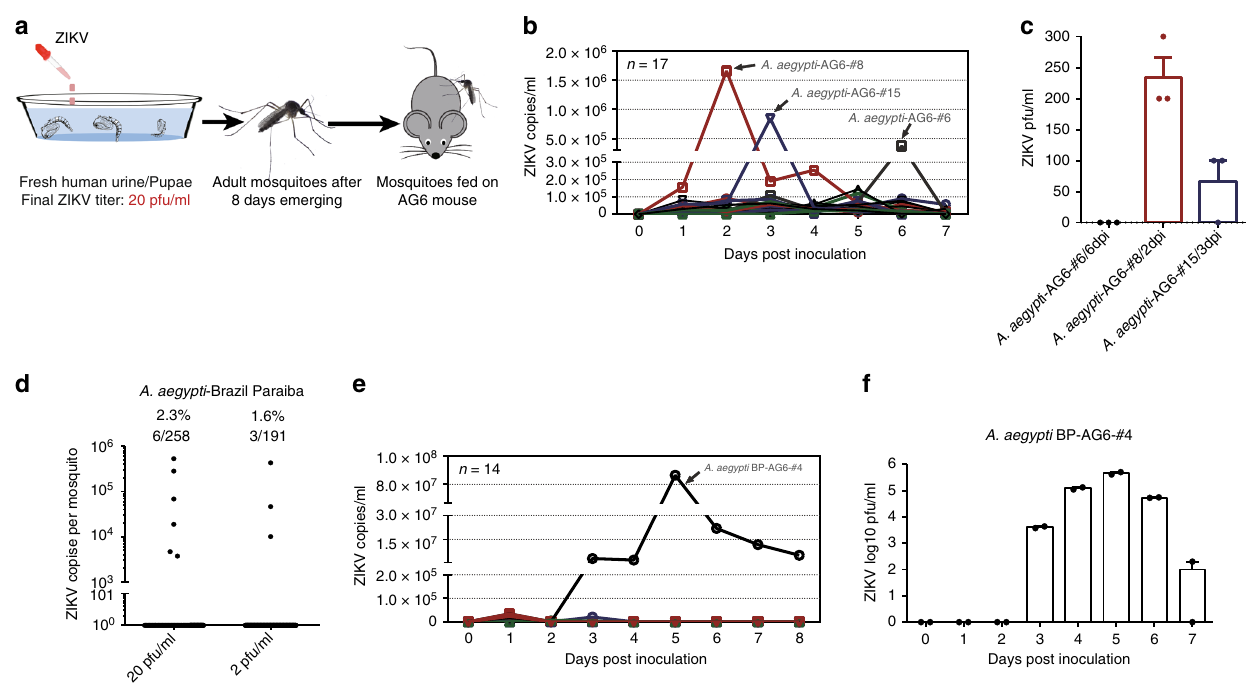
Fig. 2 Zika virus (ZIKV) is transmissible between AG6 mice and mosquitoes breeding in ZIKV urine. a Schematic representation of the ZIKV transmission between AG6 mice and mosquitoes breeding in the ZIKV urine. The A. aegypti pupae were breeding in the ZIKV urine ( fi nal ZIKV titer was 20 pfu/ml). The urine from human Donor 3 (Fig. 1a) was used in these experiments. After rearing for 8 days after adults emerged, 20 emerged female mosquitoes were allowed to feed together on an AG6 mouse. The mouse viremia was determined over a time course. b , c ZIKV viremia in the mosquito-bitten AG6 mice. The A. aegypti Rockefeller strain was used in this experiment. d Acquisition of ZIKV infection by a fi eld A. aegypti Brazil Paraiba strain breeding in infectious human urine. With the same experimental procedure as Fig. 1c, both ZIKV prevalence and infectivity were determined in the A. aegypti Brazil Paraiba strain breeding in human urine with a serial ZIKV titration. The emerging adults were reared for 8 days for subsequent ZIKV detection by TaqMan quantitative PCR (qPCR). The number of infected mosquitoes relative to the total number of mosquitoes is shown at the top of each column. One dot represents one mosquito. The percentages are represented as the ratios of mosquito infection. e , f ZIKV viremia in the AG6 mice bitten by the A. aegypti Brazil Paraiba mosquitoes breeding in human urine. b , e The presence of ZIKV RNA copies in whole blood was assessed using quantitative reverse transcription PCR (RT-qPCR) detection. n represents the mouse number used in the experiment. The results were pooled from three detection replicates. c , f The numbers of infectious particles at the viremic peak were detected by a plaque assay. c n = 3 detection replicates. f n = 2 detection replicates. Data are presented as the mean ± SEM. b – f Source data are provided as a Source Data fi